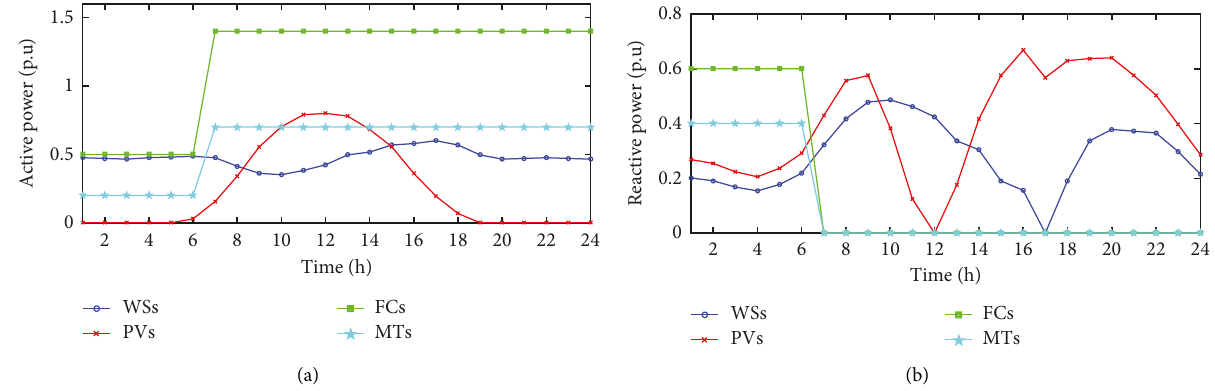
Figure 6: Expected daily curve of (a) DGs active power and (b) DGs reactive power.